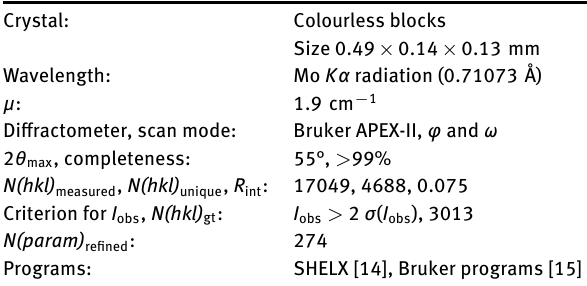
The asymmetric unit of the title crystal structure is shown in the figure. Tables 1 and 2 contain details of the measurement method and a list of the atoms including atomic coordinates and displacement parameters. Table 1: Data collection and handling.